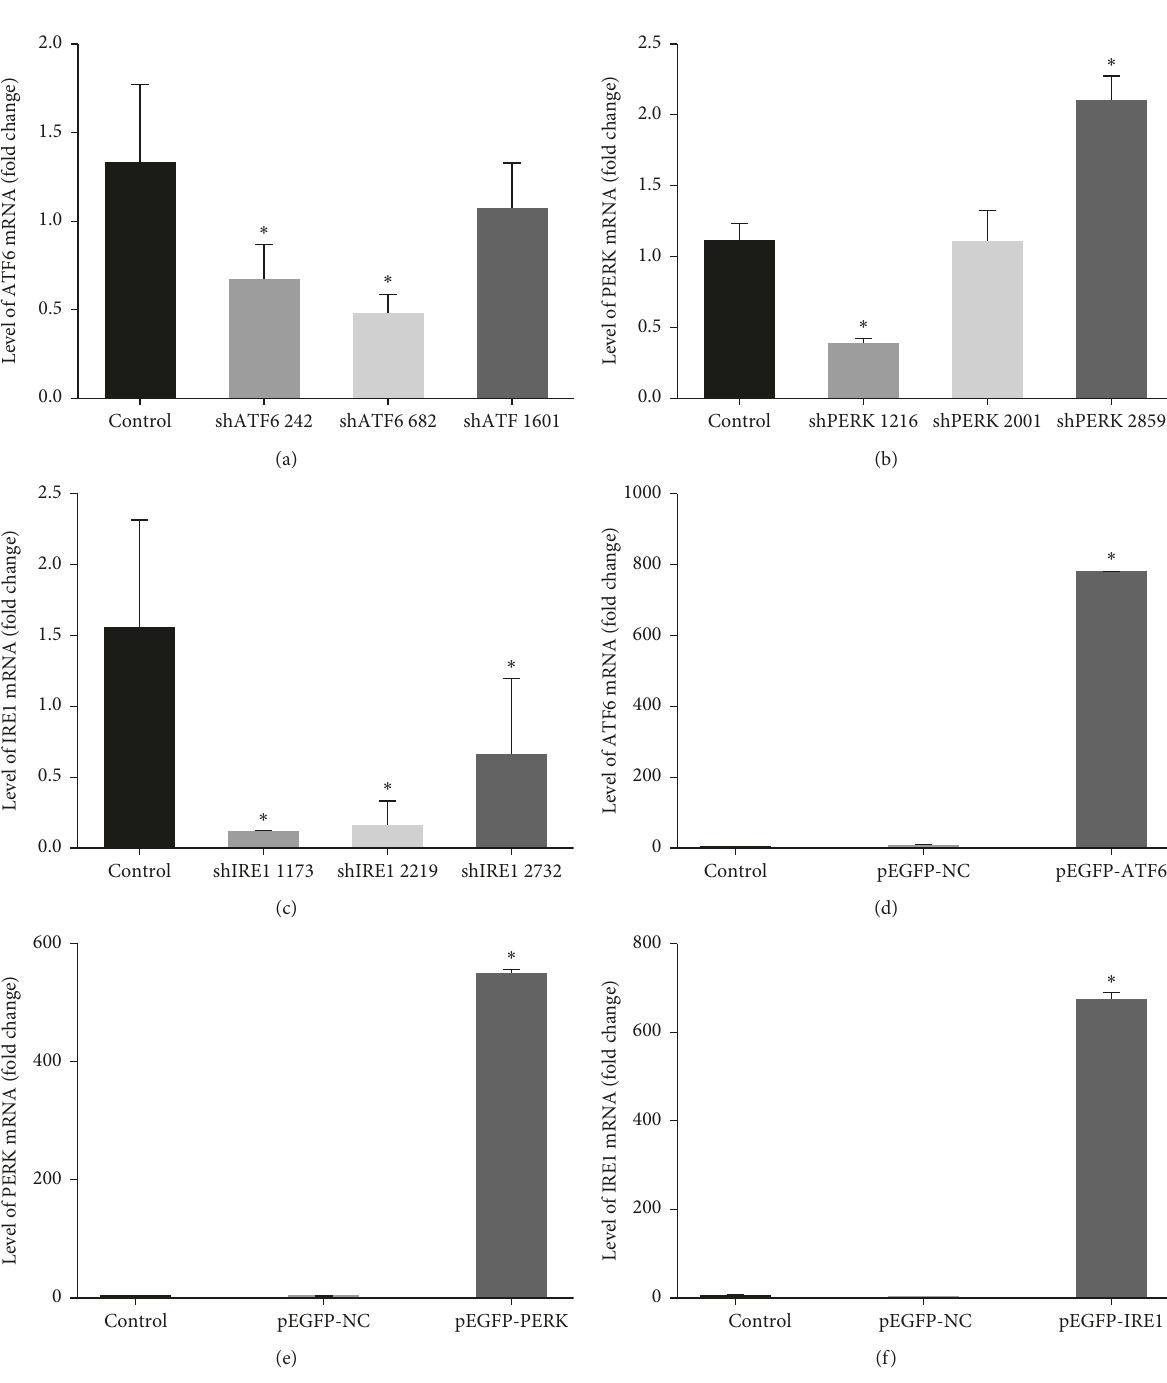
Figure 3: Transcriptional modulation by UPR pathway regulation in rMCs. The amounts of ATF6, IRE1, and PERK mRNAs in rMCs with shRNA and overexpression plasmids were determined by PCR analysis. (a) ATF6 silencing with 3 shRNAs (shATF6 242, shATF6 682, and shATF6 1601). (b) PERK silencing with 3 shRNAs (shPERK 1216, shPERK 2001, and shPERK2859). (c) IRE1 silencing with 3 shRNAs (shIRE1 1173, shIRE1 2219, and shIRE1 2732). (d) The mRNA levels of ATF6 after pEGFP-ATF6 transfection in rMCs. (e) The mRNA levels of PERK after pEGFP-PERK transfection in rMCs. (f) The mRNA levels of IRE1 after pEGFP-IRE1 transfection in rMCs. All experiments were performed in triplicates (control (mock transfected); ∗ p < 0 .